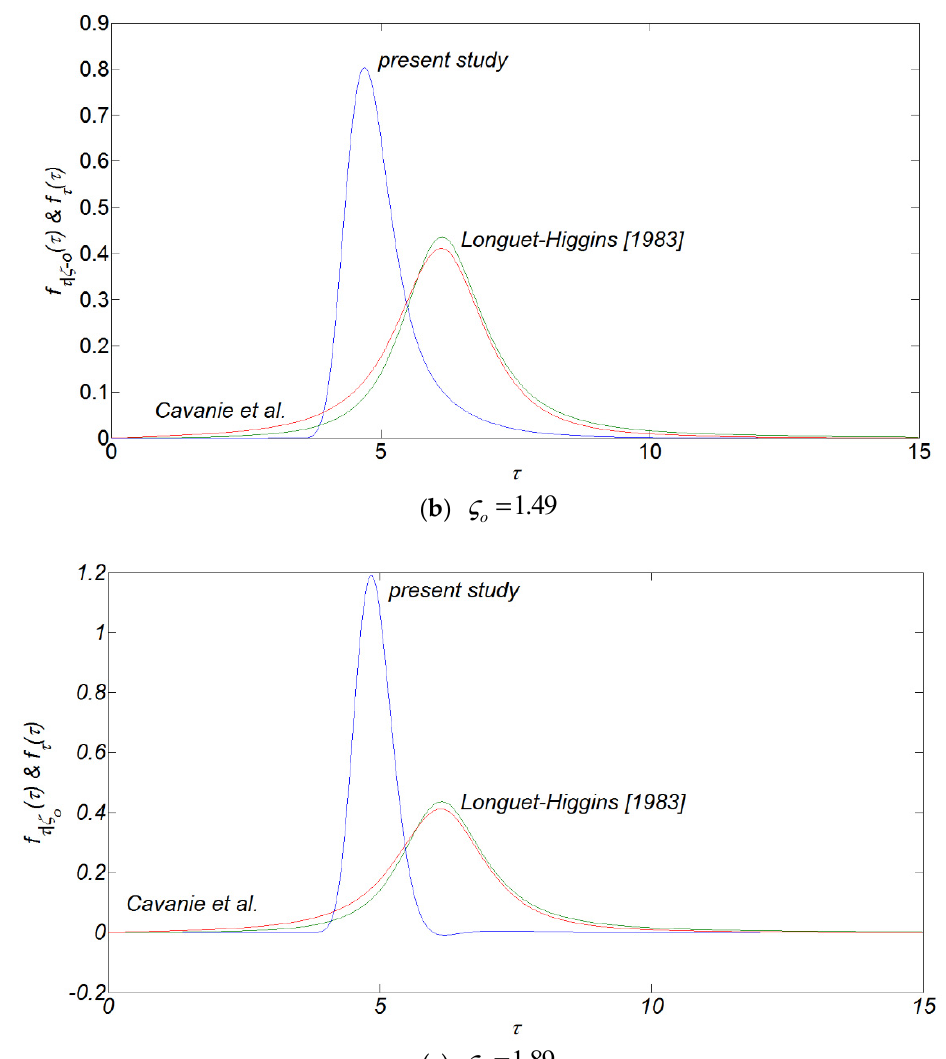
( ) τ ( τ ) in Equation (80) with Longuet-Higgins [3] and Cavanie et al. f in Equation (80) with Longuet-Higgins [3] and Cavanie et al. [25]. o ςτ | o